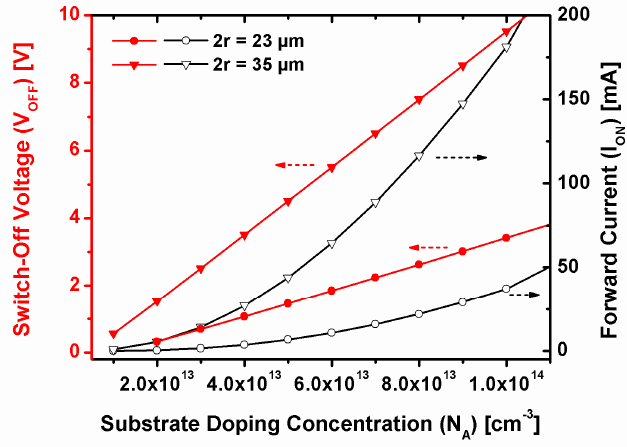
Figure 3. Simulated switch-off voltage, V OFF , ( red curves ) and forward current at saturation, I ON , ( black curves ) as a function of the substrate doping concentration, N A , for a given V-JFET design with two different cell diameters (2 r = 23 and 35 µm), and a total active area A = 5 × 5 mm 2 .